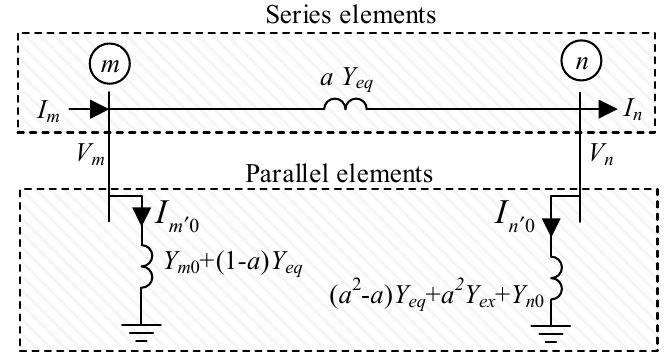
Figure 4. Equivalent model of a transformer with a secondary-side tap.